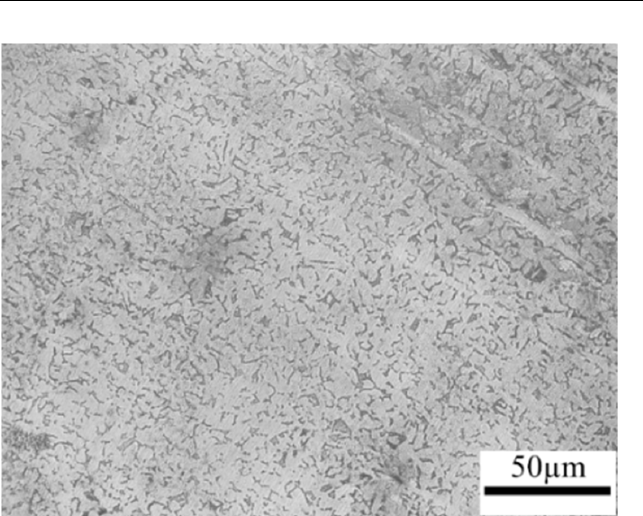
Figure 3. Initial microstructure of BR1500HS.